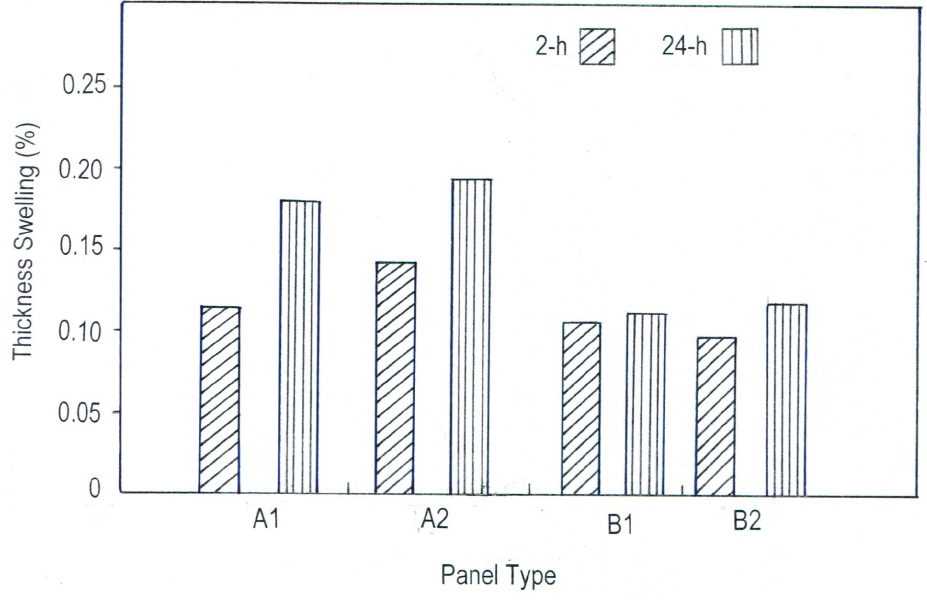
Figure 5. Thickness swelling of the samples.